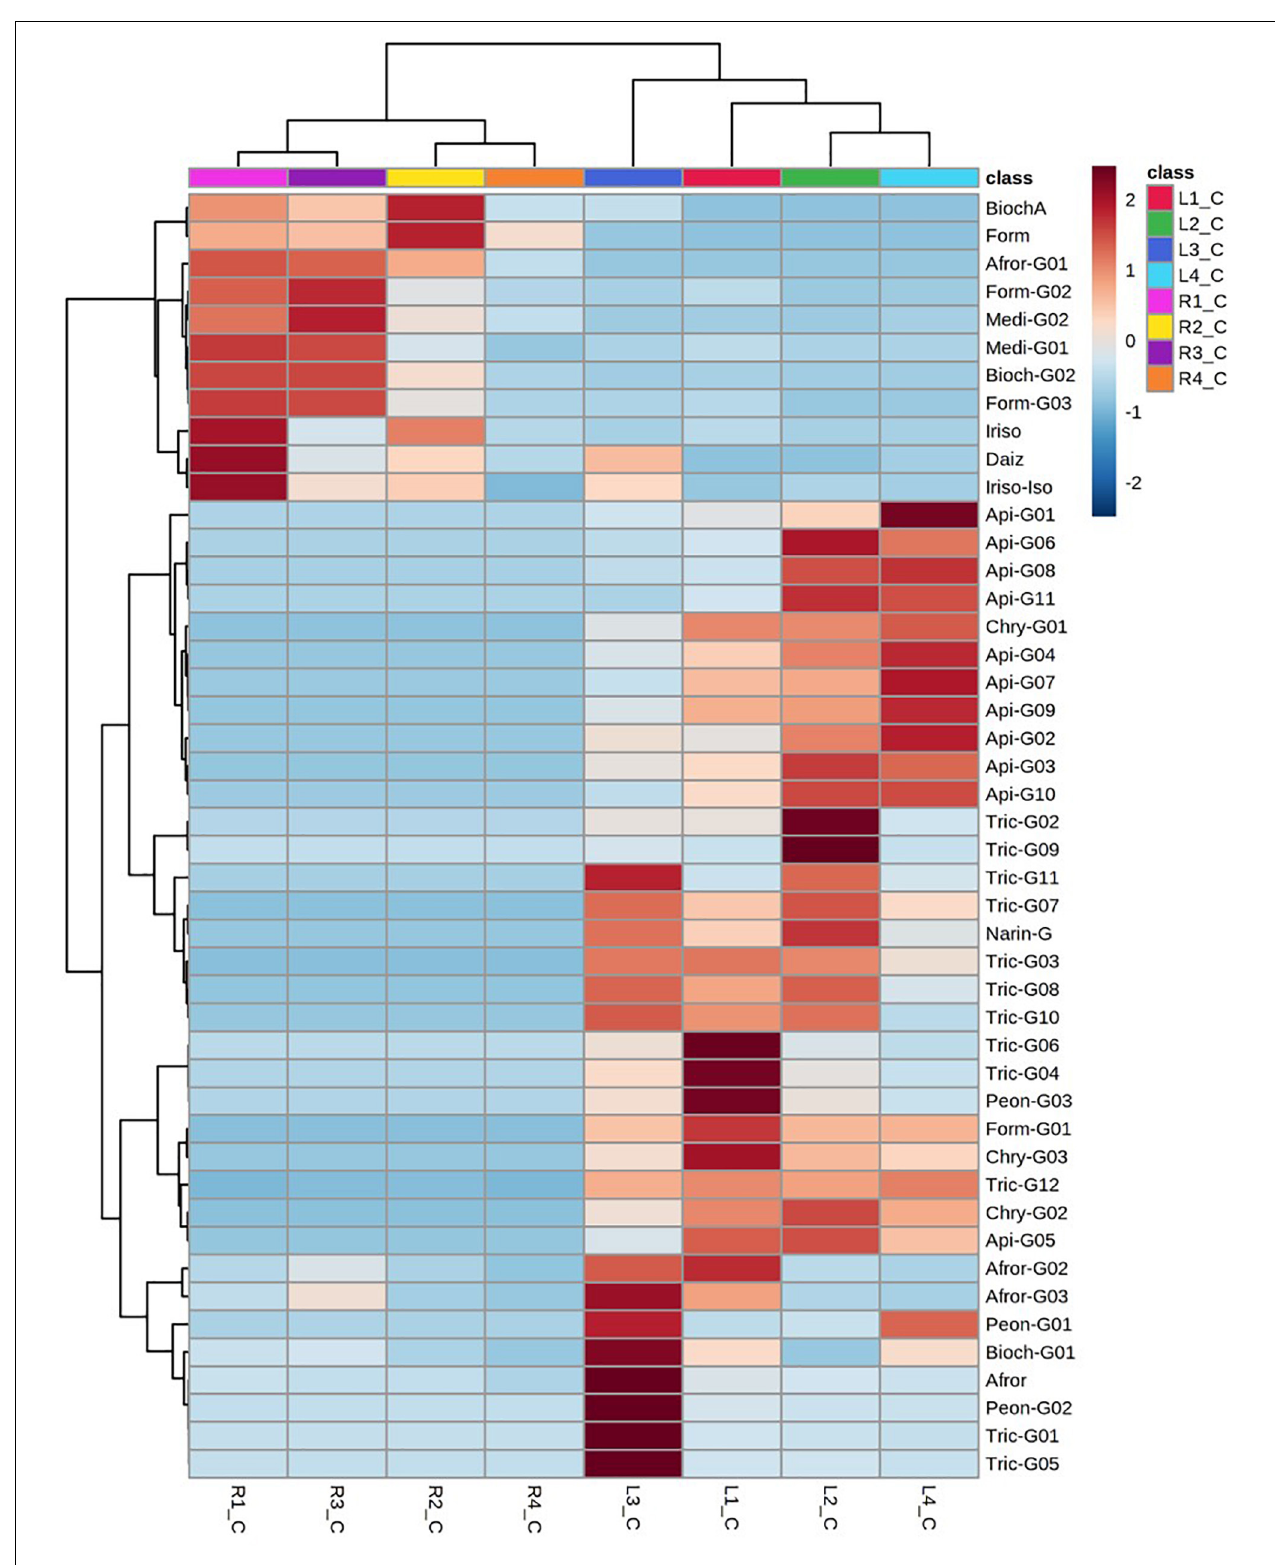
FIGURE 4 | Dendrogram and heatmap of the flavonoids and their glycoconjugates in Medicago truncatula leaves (-L) and roots (-R).